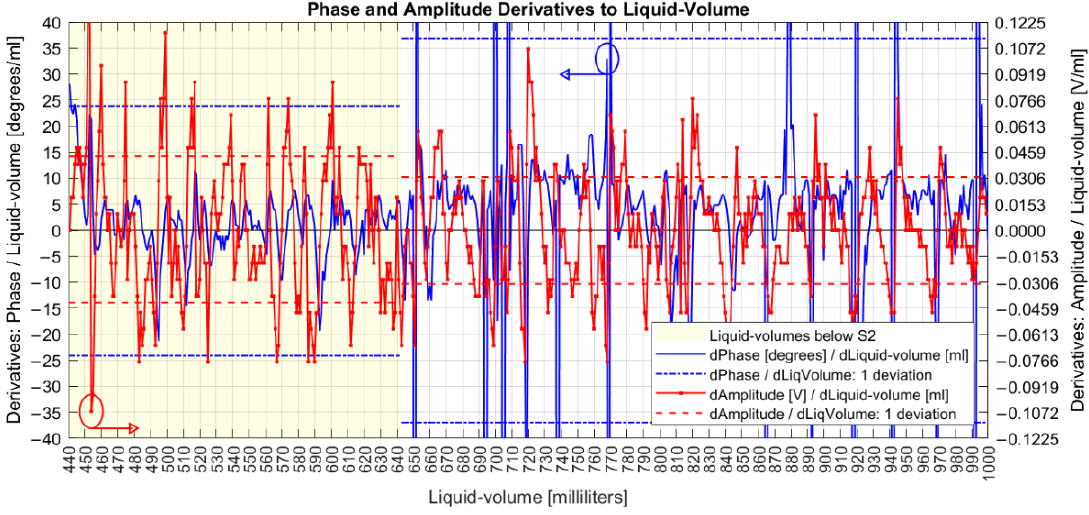
Figure 9. Derivatives of amplitudes and corrected phases.